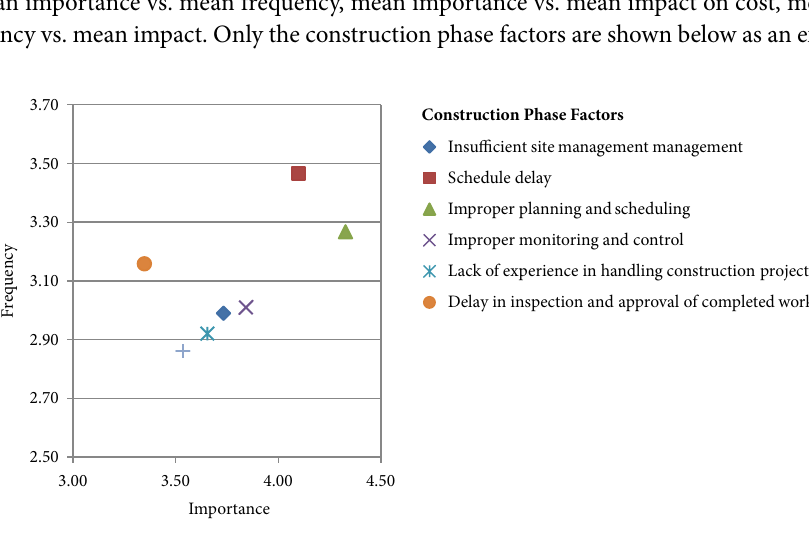
Figure 2. Risk matrix chart for cost overruns related to Construction Phase (Frequency vs.